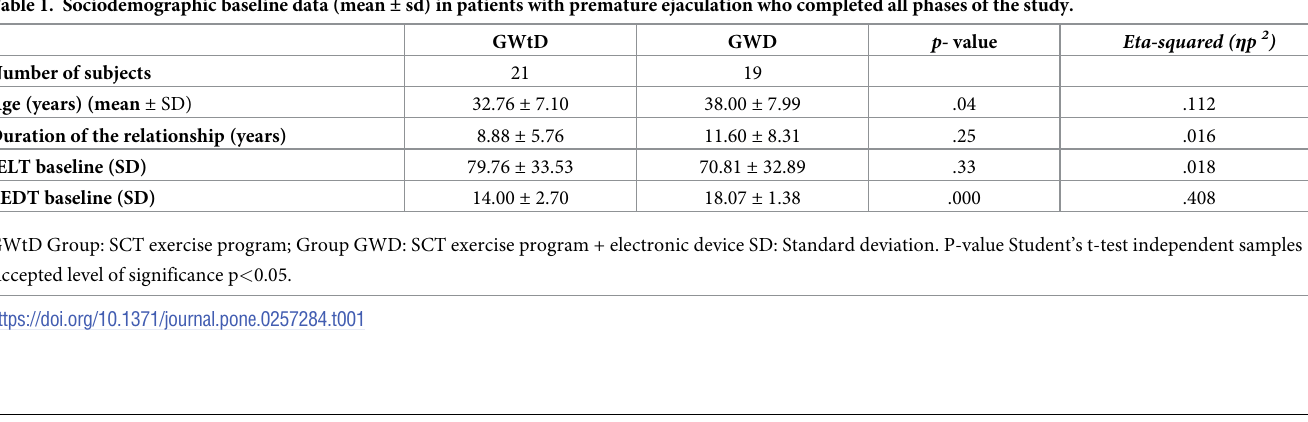
Table 1. Sociodemographic baseline data (mean ± sd) in patients with premature ejaculation who completed all phases of the study.